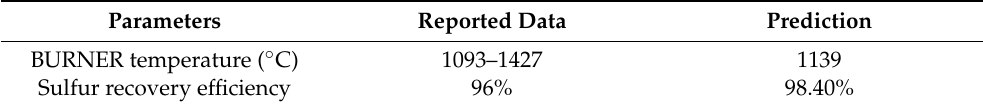
Table 3. Comparison of subunit forecasts with reported data of